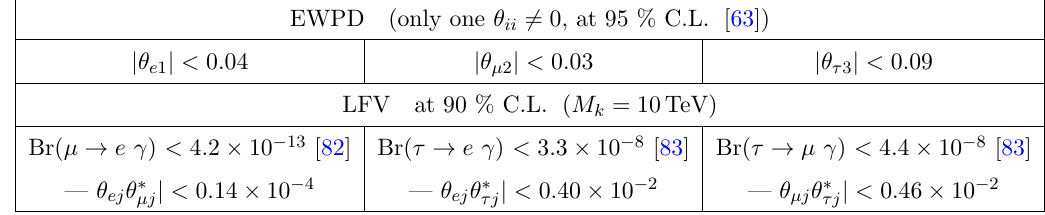
Table 1 . Limits on the mixing between the SM and the heavy quasi-Dirac neutrinos from electro- weak precision data (top) and from lepton (cid:13)avor violating processes (bottom). The sum on the repeated index j = 1 ; 2 ; 3 is